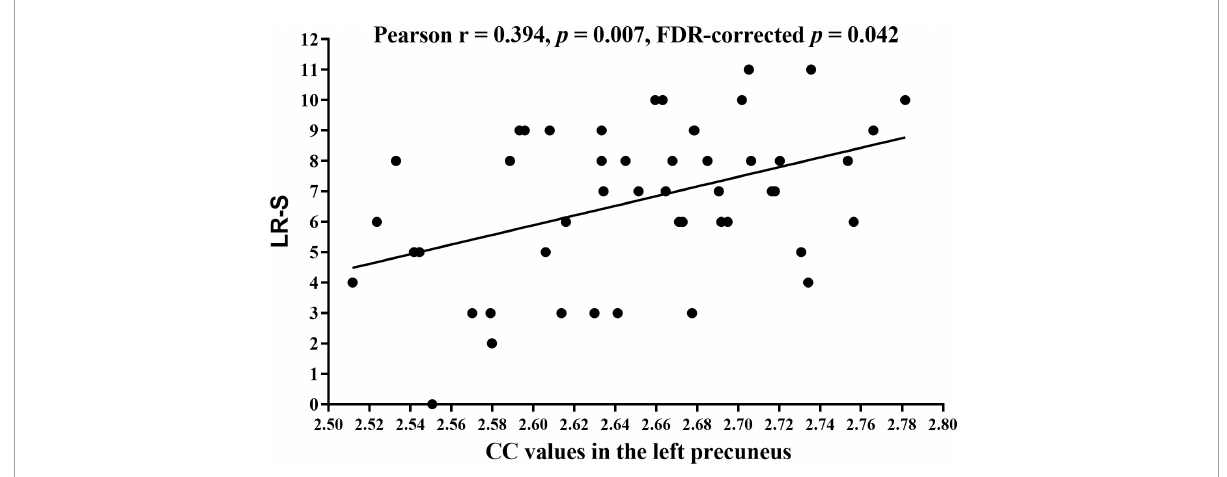
FIGURE4 Correlation analysis between the CC values of the left precuneus and LR-S in patients with ESKD. Pearson correlation analysis showed lower CC values of the left precuneus were associated with lower LR-S (Pearson r = 0.394, p = 0.007, FDR-corrected p = 0.042) after adjusting for age, sex, and education level. CC, cortical complexity; LR-S, long-term delayed recall score; ESKD, end-stage kidney disease; FDR, false discovery